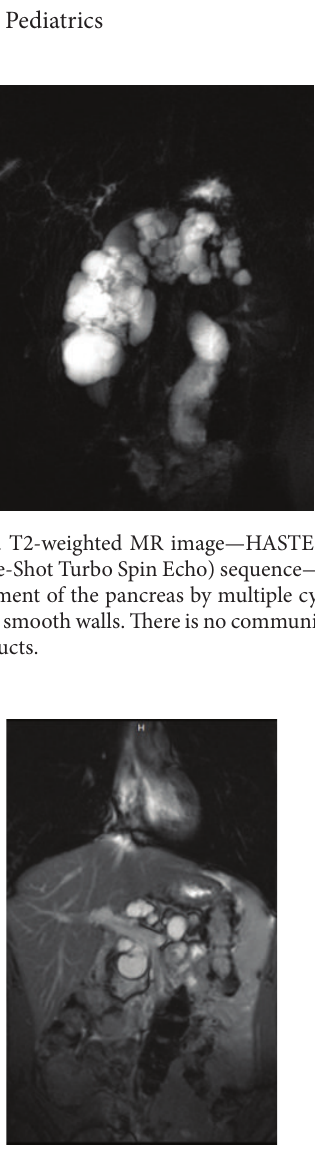
Figure 4: T2-weighted coronal MR image—TRUFI (True Fast Imaging with steady-state-free precession) sequence—obtained at the level of the portal-splenic venous confluence shows multiple high signal cysts of varying size replacing the